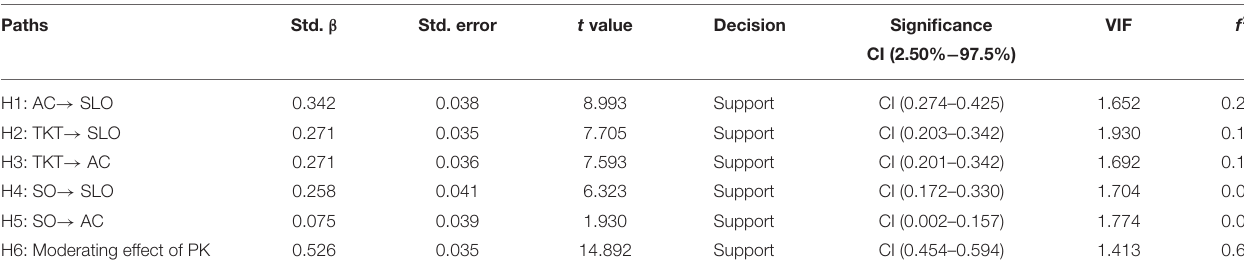
TABLE 2 | Results of the hypotheses testing. Paths Std. β Std. error t value Decision Significance VIF f